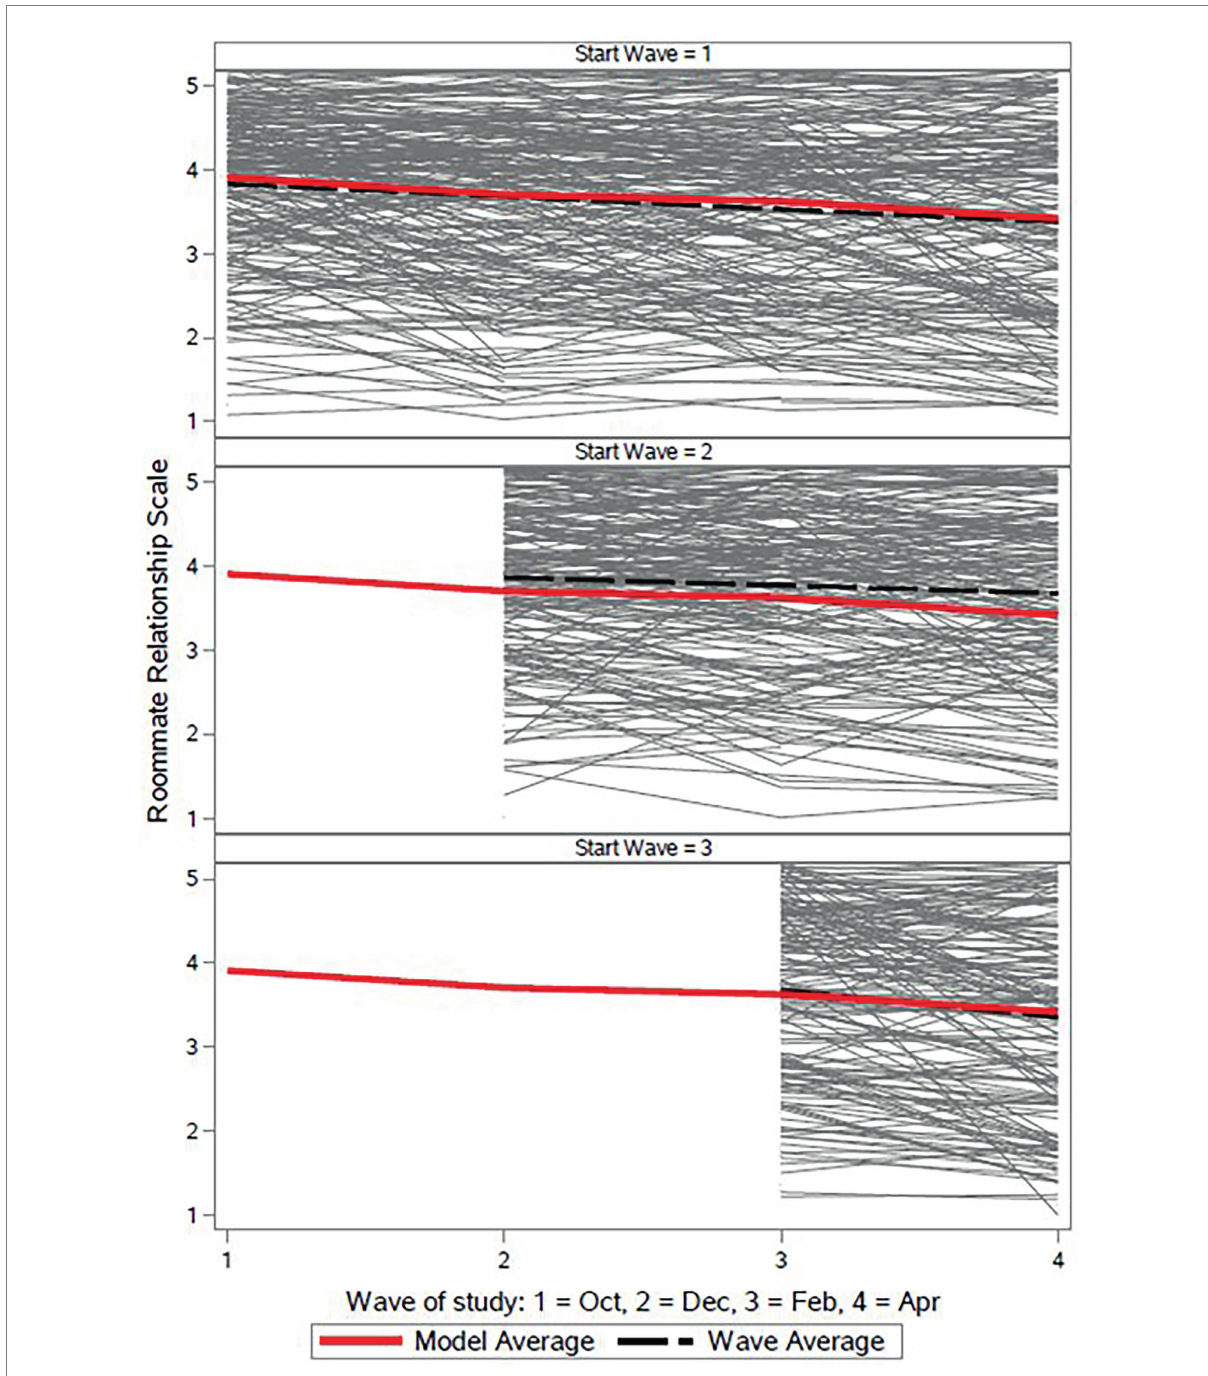
FIGURE 2 Individual and model estimated average trajectories of the Roommate Relationship Scale across the starting waves. Individual trajectories in each panel reflect participants who started at the first (Top panel), second (Middle panel), and third waves (Bottom panel), respectively. The red line in each panel indicates the multilevel linear model estimate across all participants and waves, while the black line in each panel represents the multilevel linear model estimate for participants who began the study at the wave specified in the panel